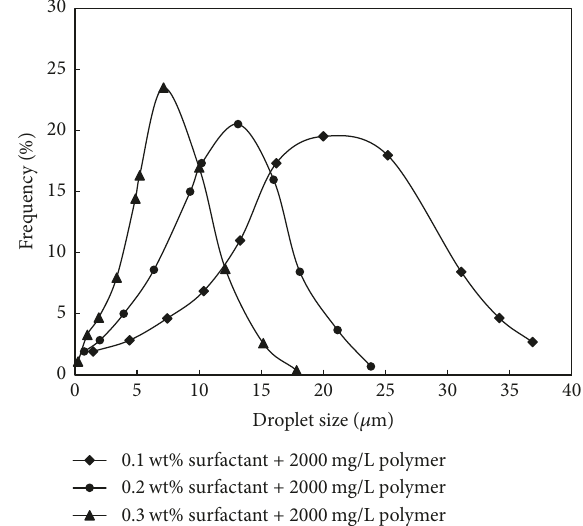
Figure 6: Distribution of emulsion droplet with different chemical